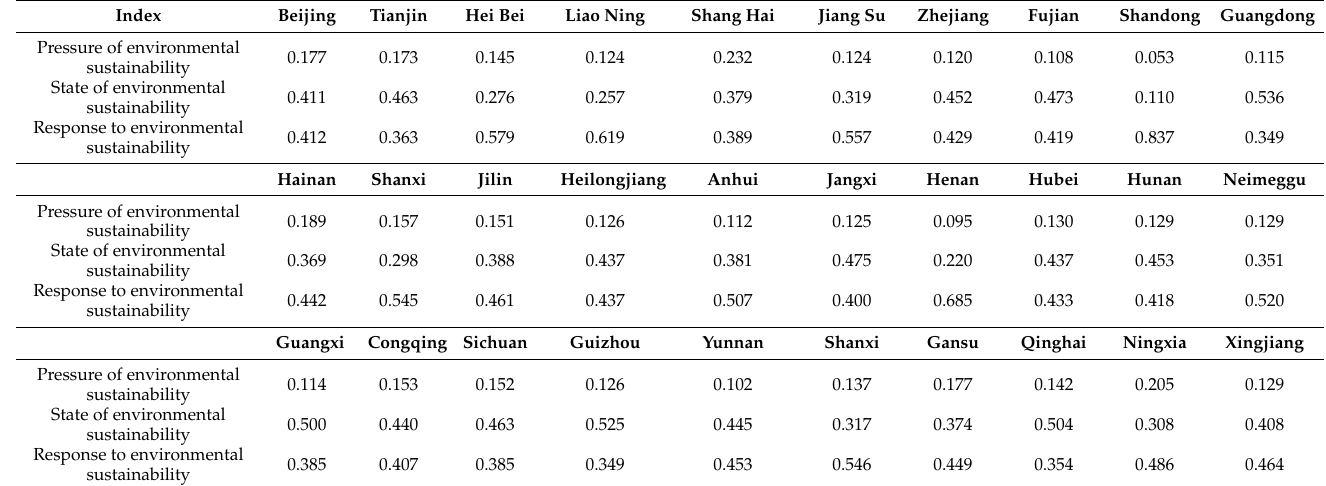
Table 7. Variable weight